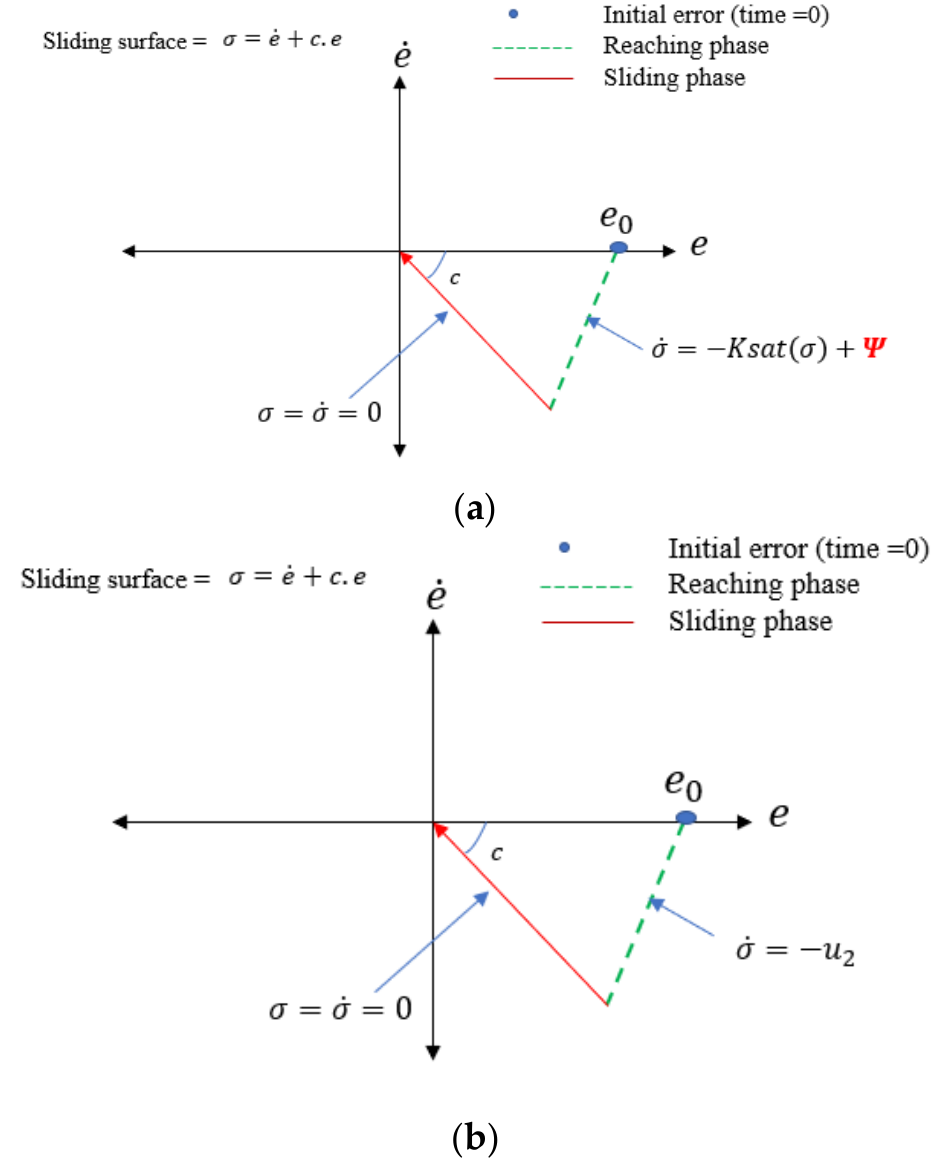
Figure 3. Effect of perturbation on sliding variable: ( a ) SMC (affected by perturbation), ( b ) ISMC (perturbation free).